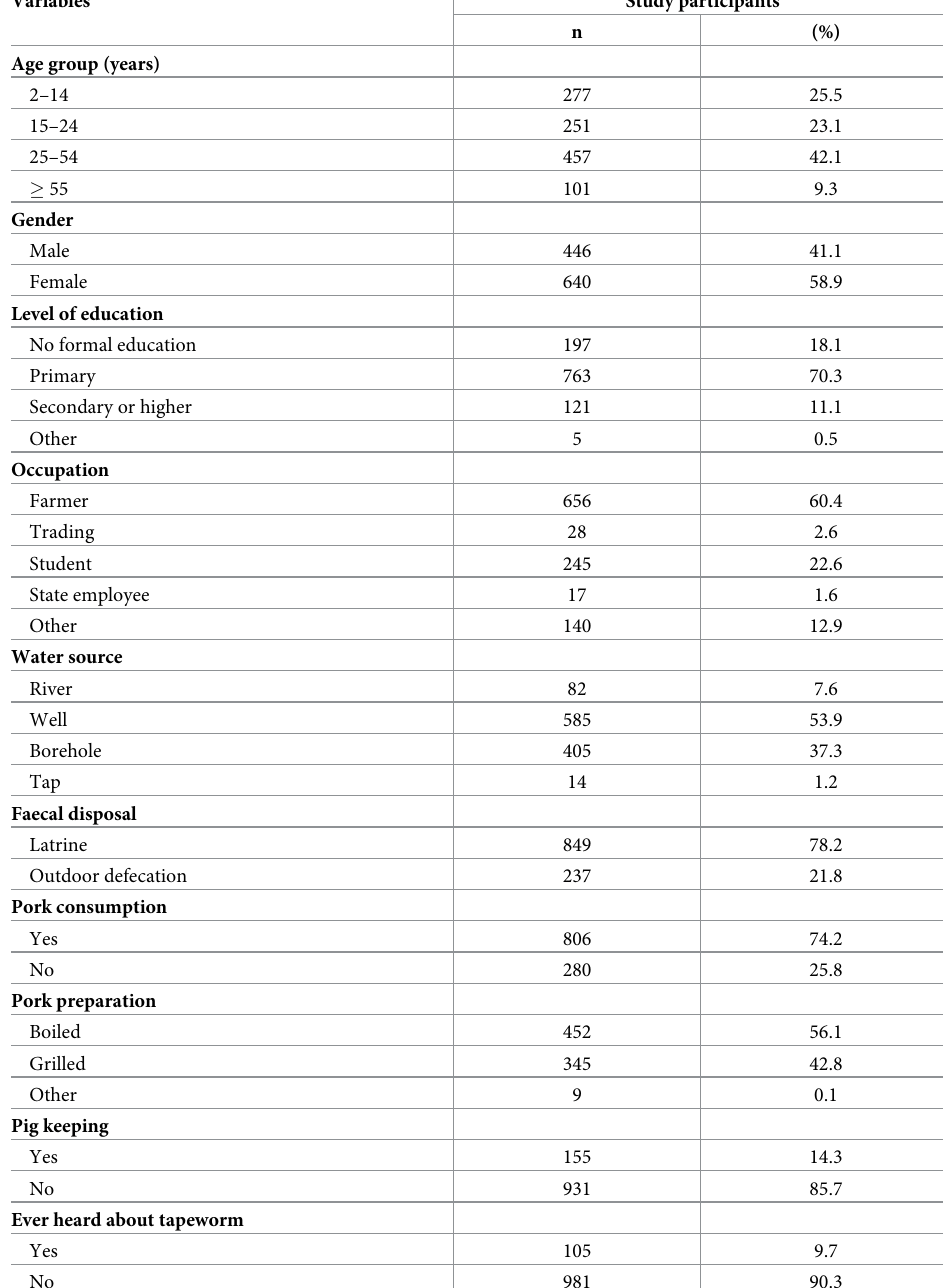
Table 1. Socio-demographic characteristics of the study